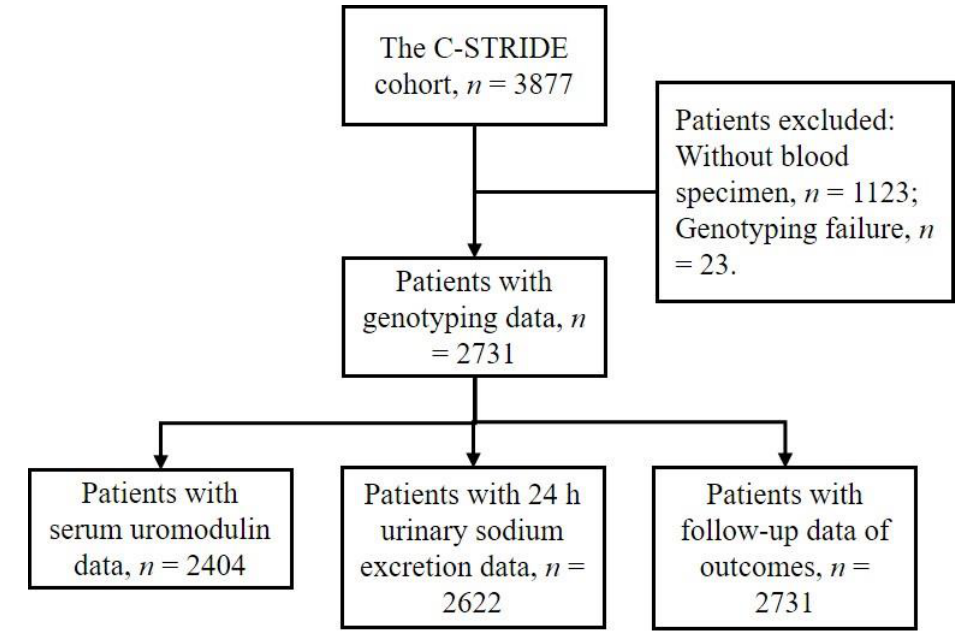
Figure 1. Flowchart of the participants selection.